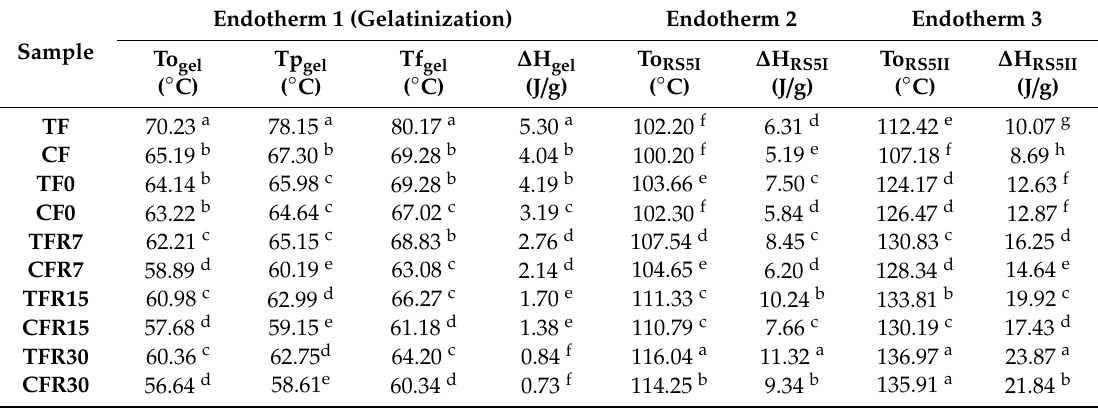
Table 5. Thermal properties of nixtamalized corn flours and corn tortilla flours obtained by the traditional and industrial